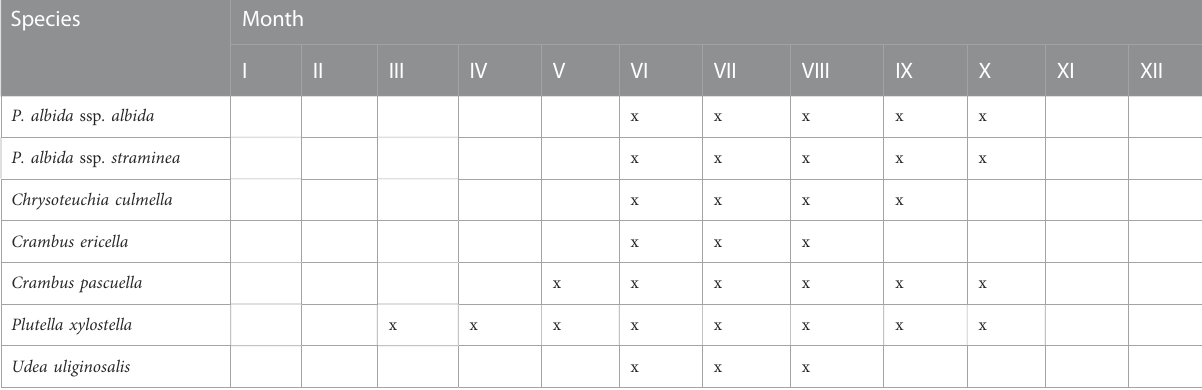
TABLE 5 Overlap of potential ranges of P. albida and its pollinators.